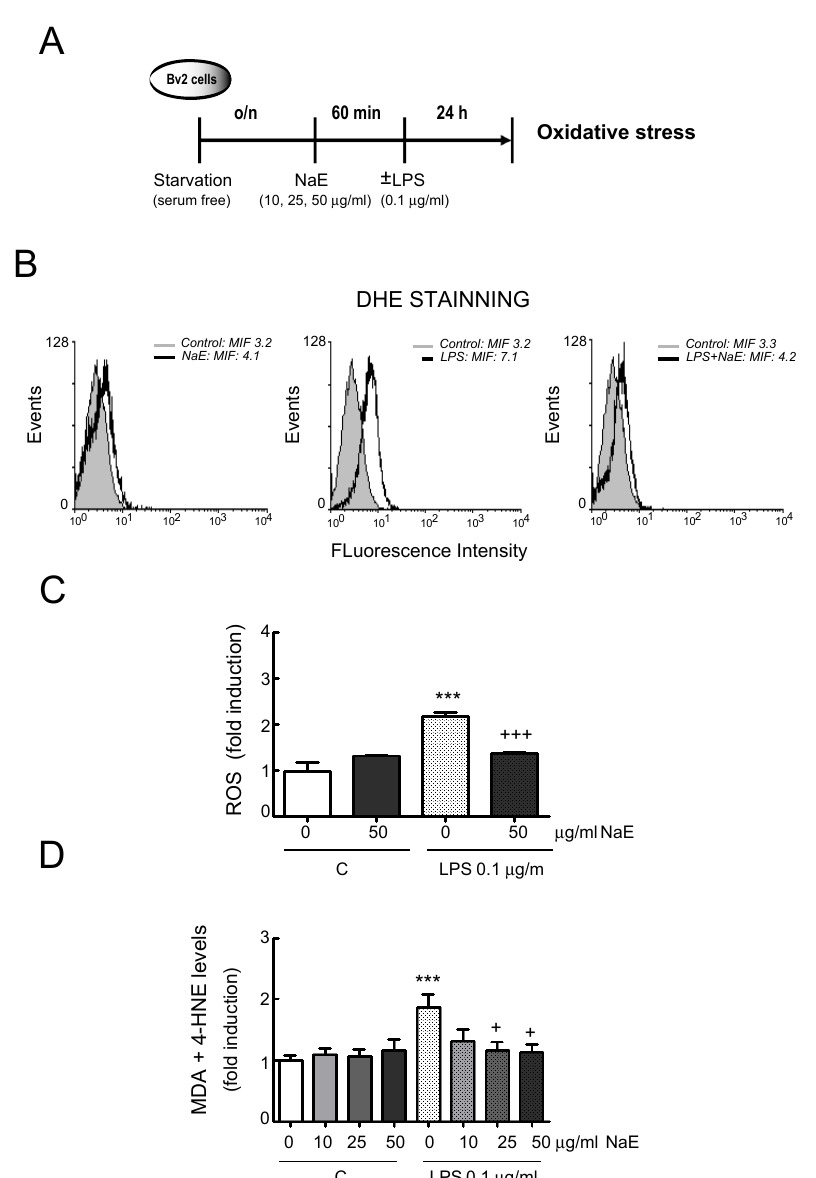
Figure 5. NaE extract modulates LPS-induced oxidative stress in BV2 microglia. ( A ) Experimental steps. Cells were pre-treated with the indicated doses of the NaE extract for 1 h and then stimulated or not with 0.1 µg/mL of LPS for 24 h. ( B ) After treatments, cells were incubated at 37 °C in the dark for 20 min with a culture medium containing 20 µM DHE to monitor intracellular superoxide anion production using flow cytometry. Representative histograms. ( C ) Quantified levels of ROS. ( D ) Lipid peroxidation (MDA + 4-HNE) levels. Values are expressed as the mean ± SD of the three independent experiments. *** p < 0.001 vs. controls; and +++ p < 0.001 and + p < 0.05 vs. LPS-treated cells.